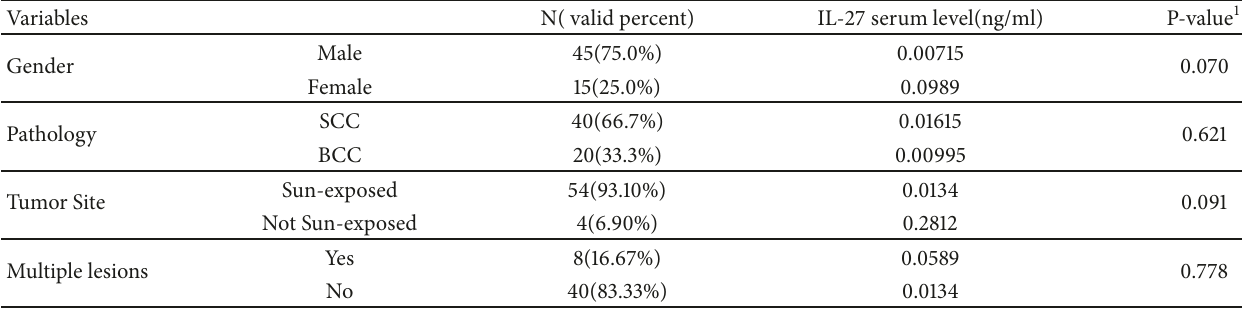
Table 1: Clinicopathologic characteristics of nonmelanoma skin cancer patients and their respective IL-27 serum levels in each subgroup.